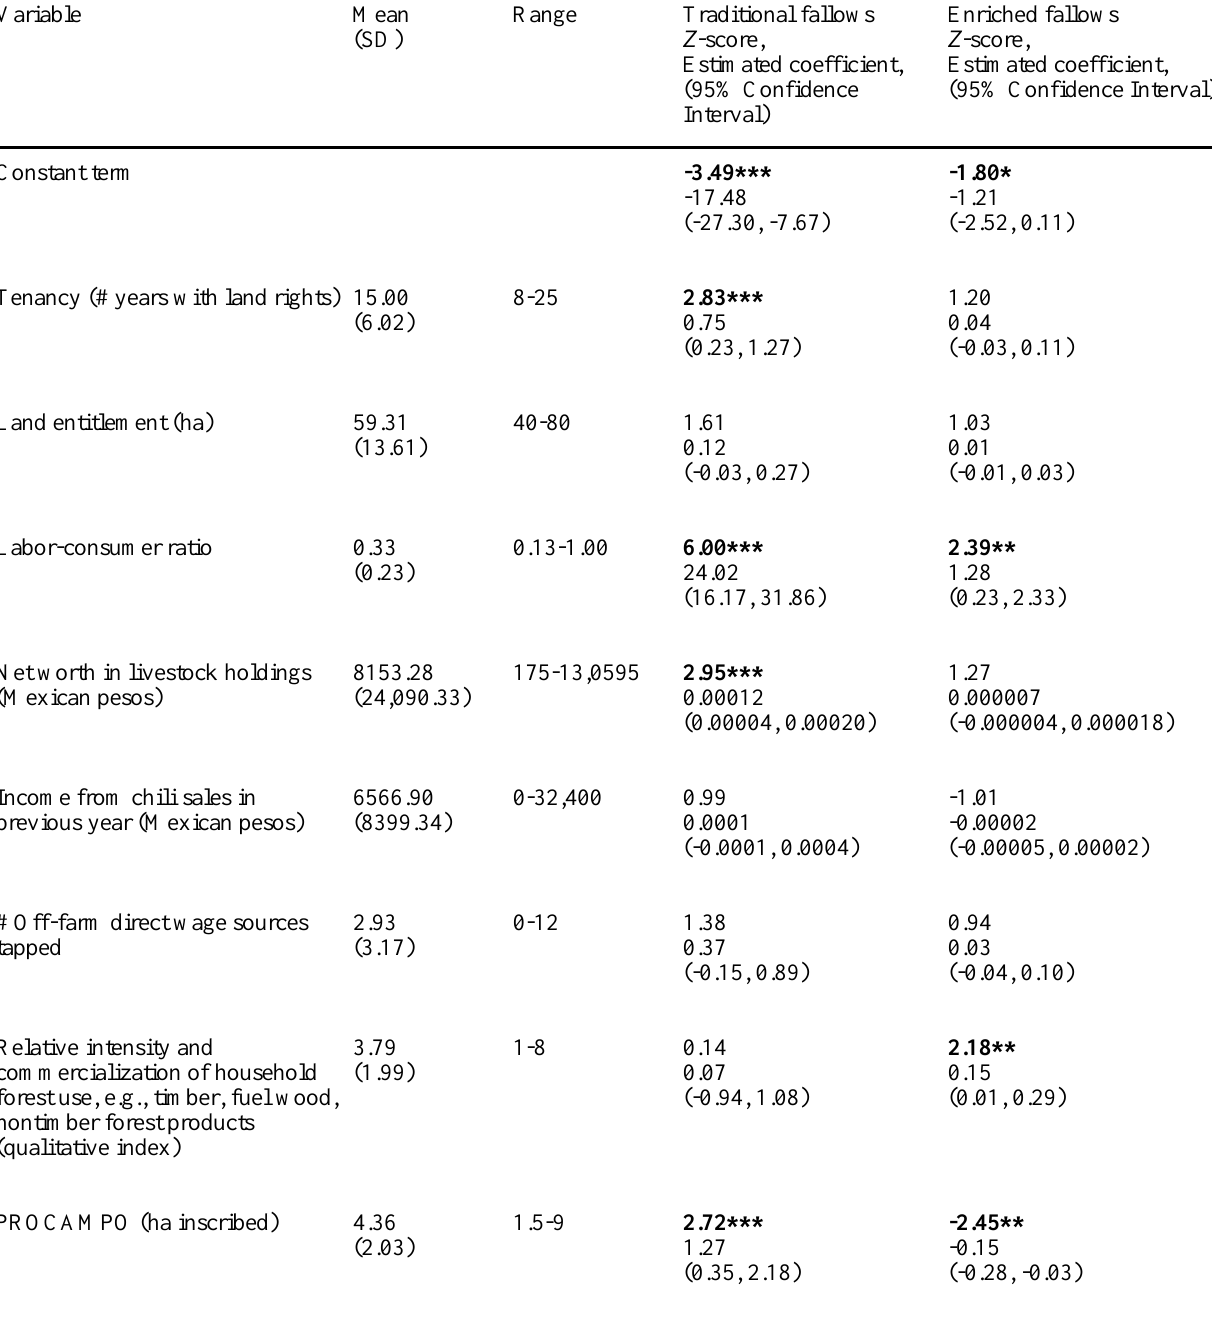
Table 1. Summary statistics of household and institutional variables and results of Seemingly Unrelated Regression for traditional and enriched fallow allocations. Cells list standardized coefficients. * P =0.10, ** P =0.05, *** P